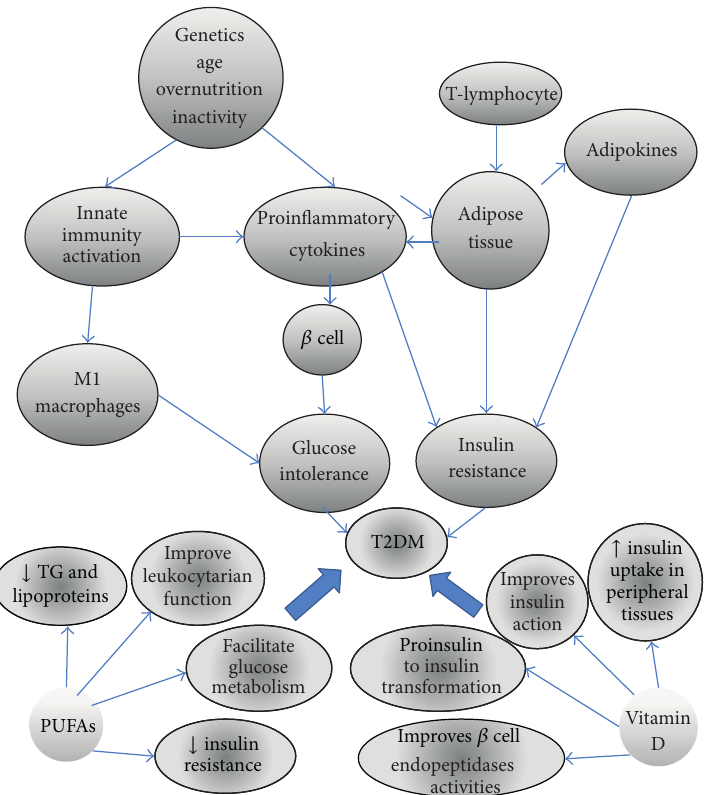
Figure 1: Diverse factors such as overnutrition, physical inactivity, age, and genetics can activate the innate immune system and consequently the production of cytokines, which by themselves lead to insulin resistance and diabetes, but there is evidence that some of these alterations can be improved through the consumption of PUFAs and vitamin